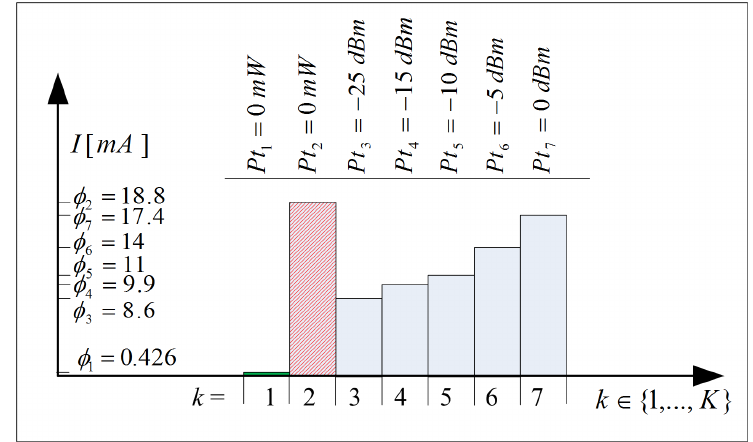
Figure 2. Available energy states of the module CC2420